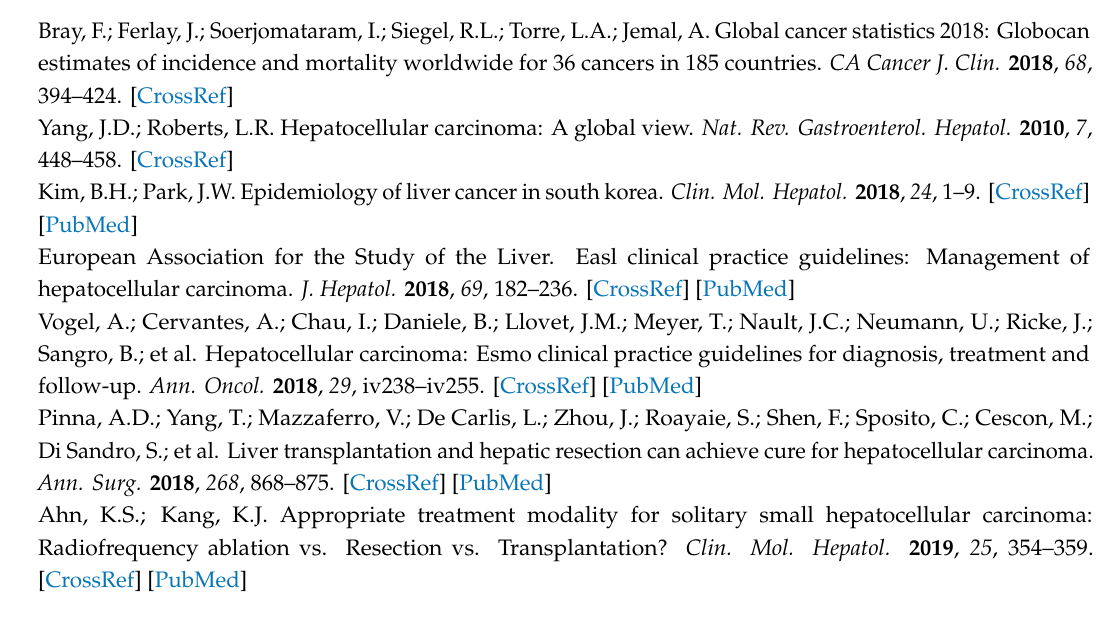
Table S1: Association between radiological and biological responses ( n = 388), Table S2: Predictors of recurrence, Table S3: Predictors of death, Figure S1: Representative images where the red and yellow arrows indicate HCC before RFA (A) and CR status after RFA (B), respectively, Figure S2: Representative images where the red and yellow arrows indicate HCC before TACE (A) and CR status after TACE (B),